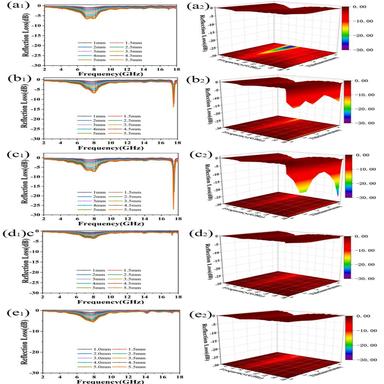
RL curves (1) and 3D maps (2) of Fe3O4@PS-1 (a), Fe3O4@PS-2 (b), Fe3O4@PS-3 (c), PS hollow spheres (d), and Fe3O4@PS- C (e).